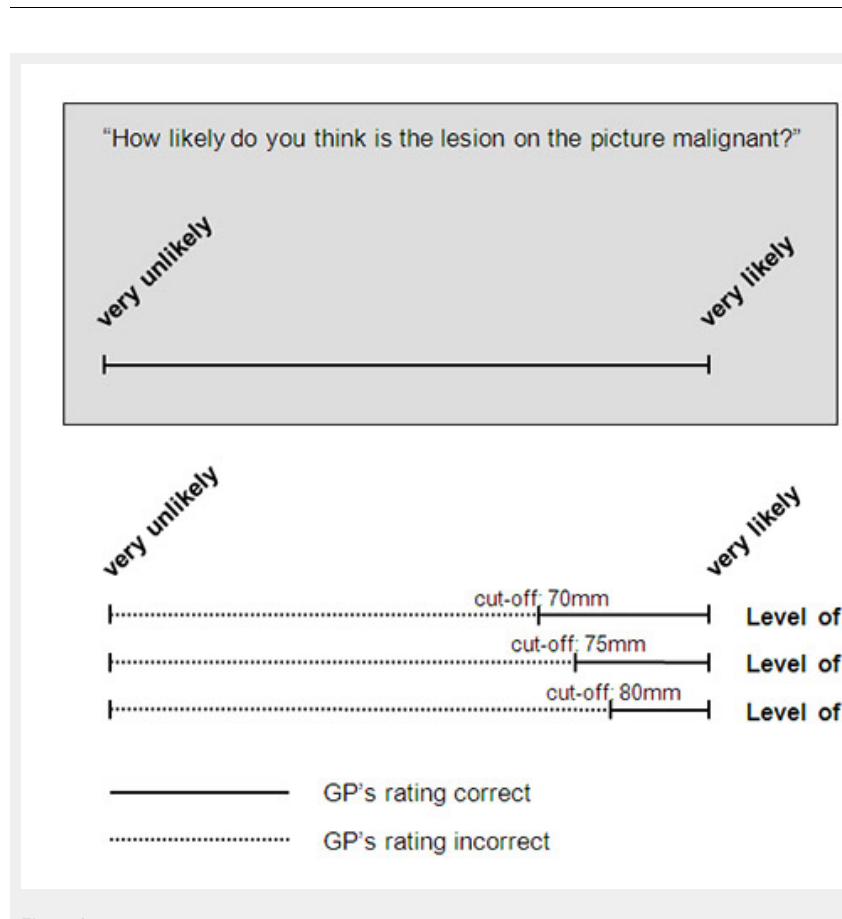
Figure 1 Example of the interpretation (picture with a malignant lesion).